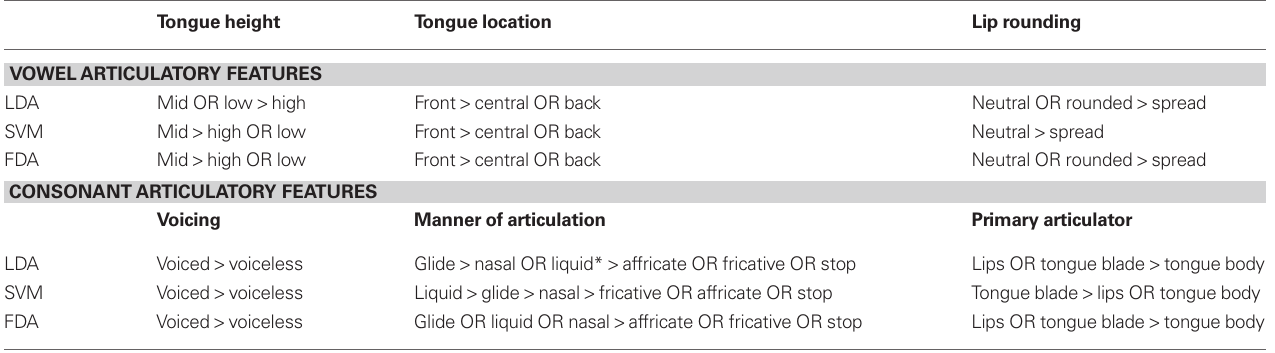
Table 4 | Vowel and consonant articulatory features are summarized with respect to classification accuracy. Tongue height Tongue location Lip